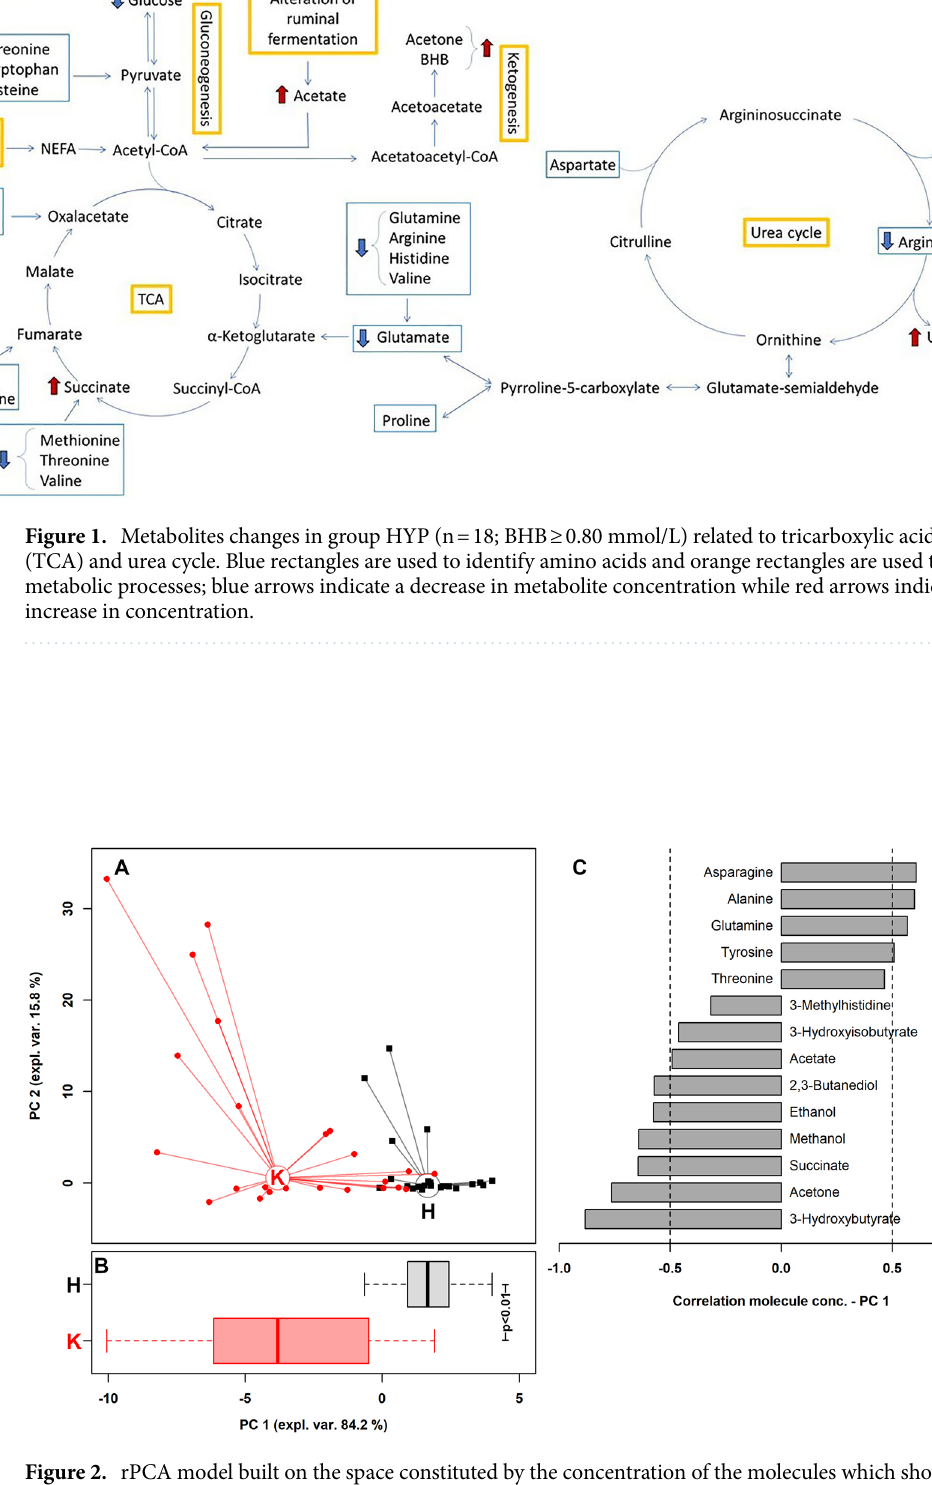
Figure 2. rPCA model built on the space constituted by the concentration of the molecules which showed a statistically significant difference between different groups. In the scoreplot ( A ), samples from the two groups are represented with black squares (Group non-HYK; n = 28; BHB < 0.80 mmol/L) and red circles (Group HYK; n = 18; BHB ≥ 0.80 mmol/L). The wide, empty circles represent the median of each samples’ group. The metabolites distribution along the principal component 1 (PC1) is summarized in the boxplot ( B ). The loading plot ( C ) reports the significant correlation between the concentration of each substance and its importance over PC 1 (p <